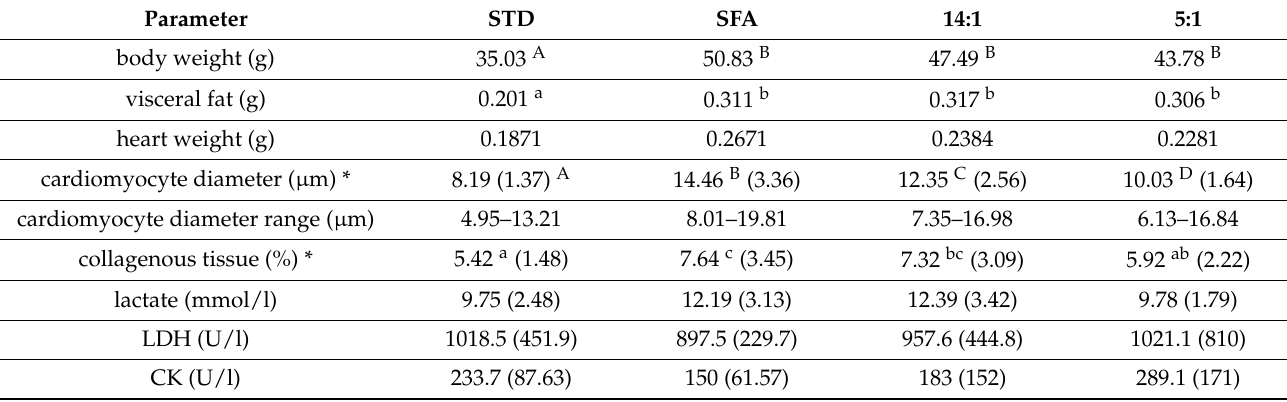
Table 2. Morphological, histological and plasma biochemical parameters after three-month diets—standard (STD), ex- perimental high-fat diets rich in saturated fatty acids (SFA), and rich in PUFA with the 14:1 n-6/n-3 and 5:1 n-6/n-3 ratios—expressed in arithmetic mean values